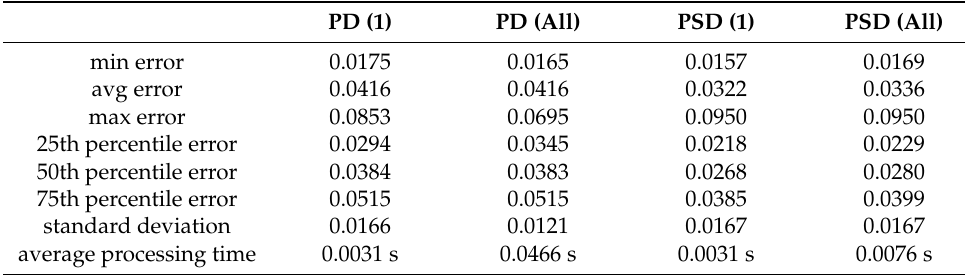
Table 4. Efficiency of modeling-based traffic prediction for SIX